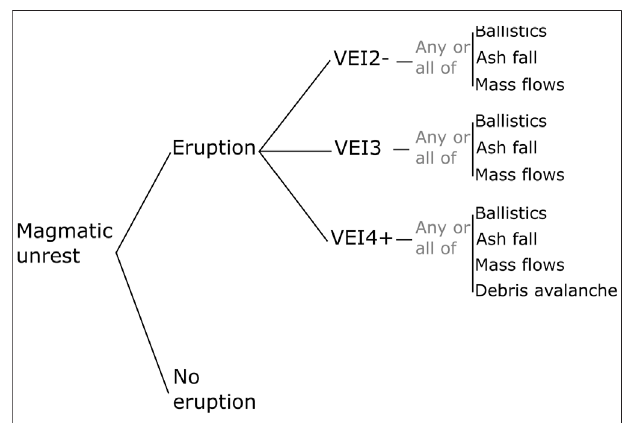
FIGURE 3 | Simpli fi ed conditional probability chain for main hazards to affect proximal infrastructure within Te Papakura o